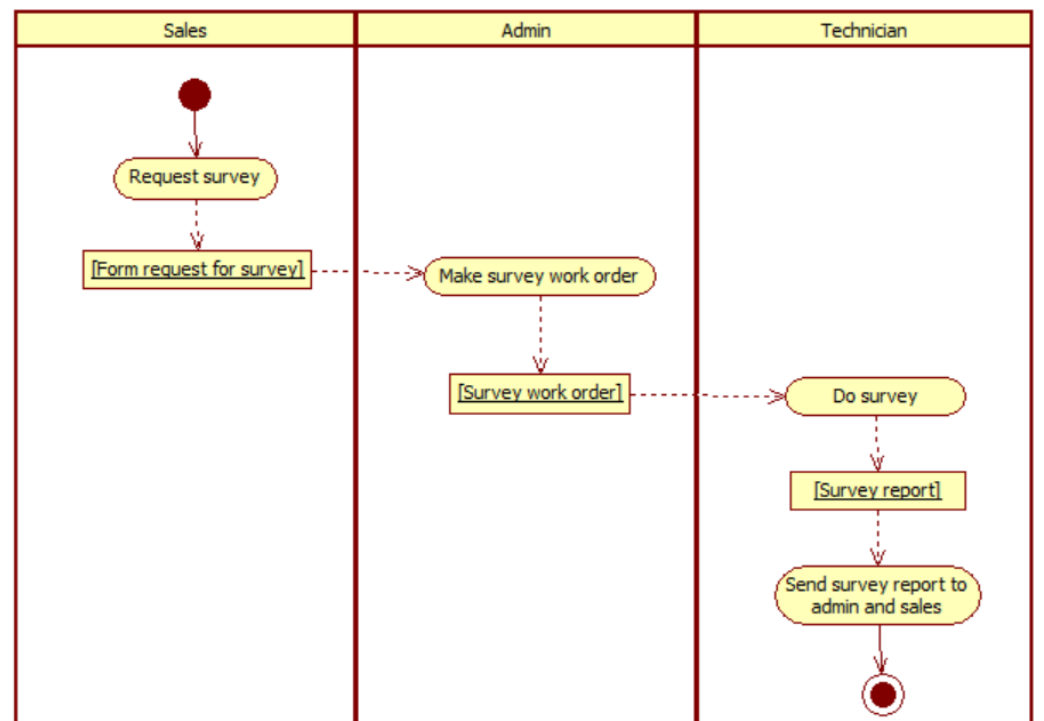
Figure 2. Request for Survey